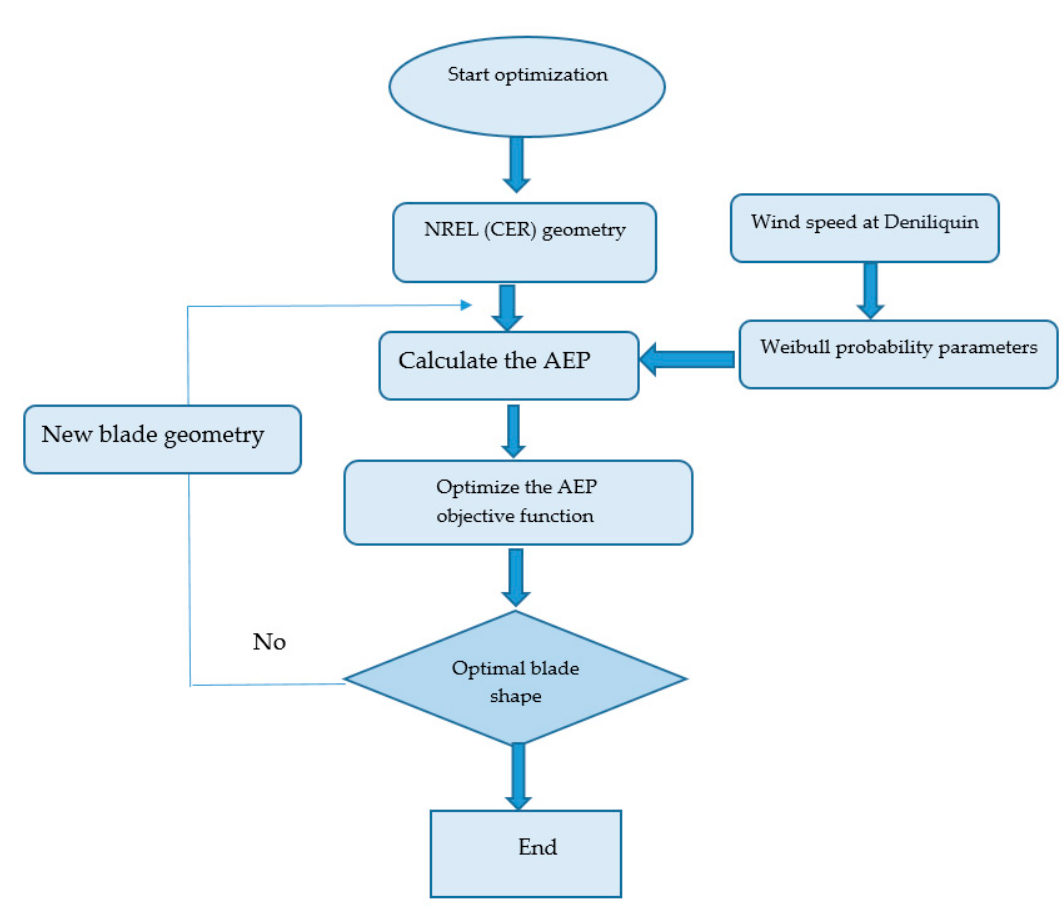
Figure 5. Optimization flowchart. Table 4. Genetic algorithm (GA) configuration.